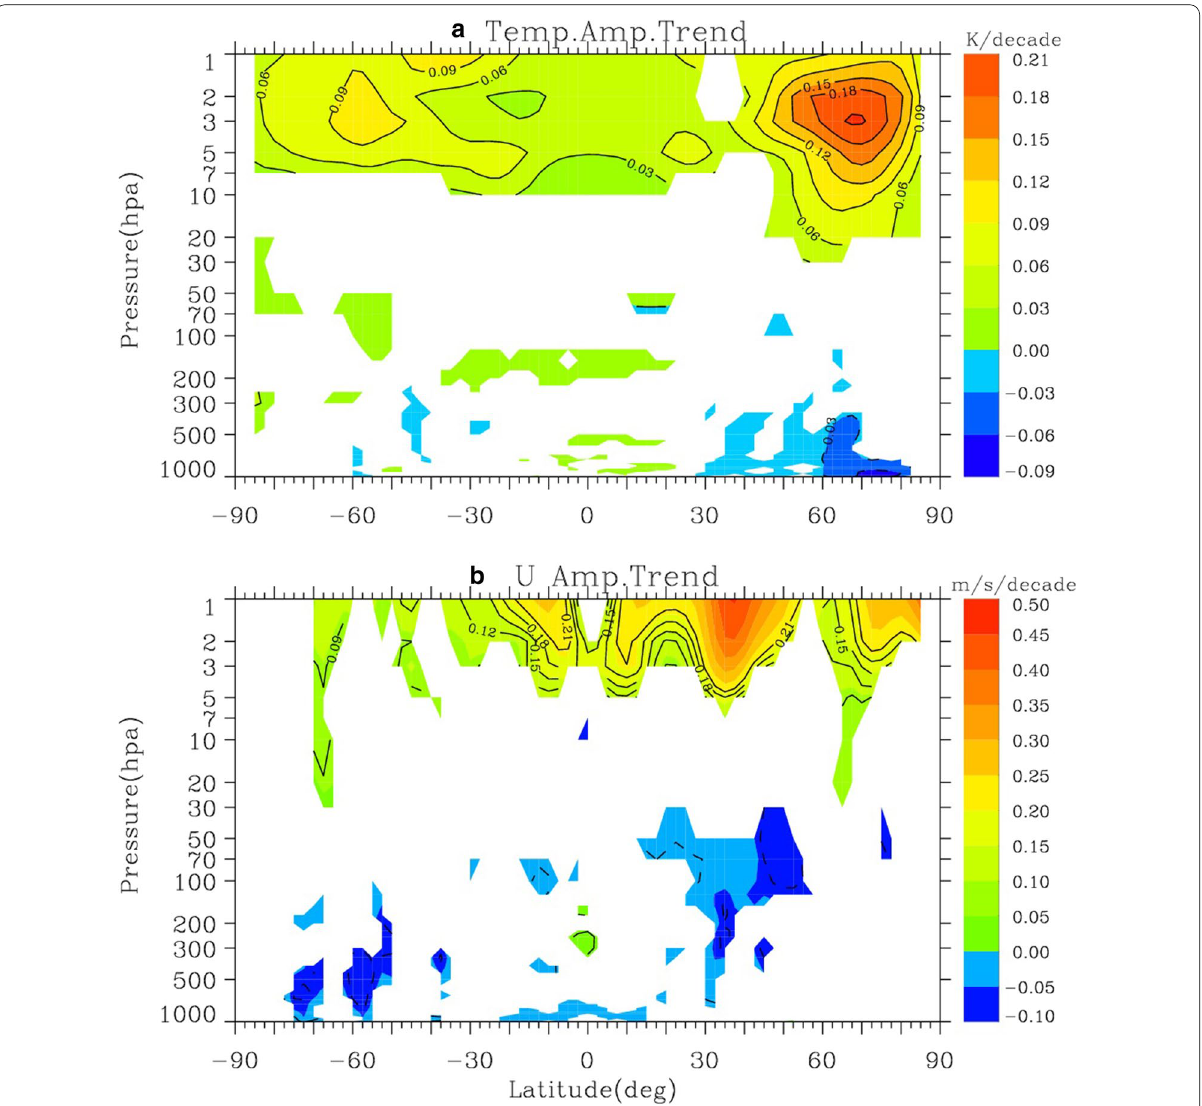
Fig. 7 Long-term trend as a function of pressure and latitude of the monthly mean Q16W1 amplitude in ( a ) temperature and ( b ) zonal wind obtained from the 39 year ERA-Interim data sets. Only the results with a confidence level at/above 95% are plotted as contours. The solid and dashed contours denote the positive and negative trends,